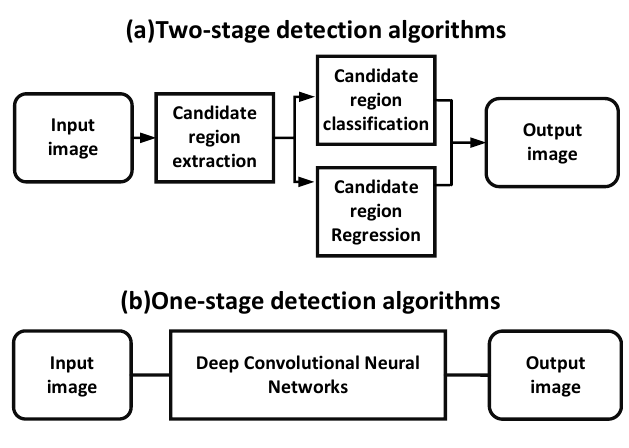
Figure 1 Different Object detection